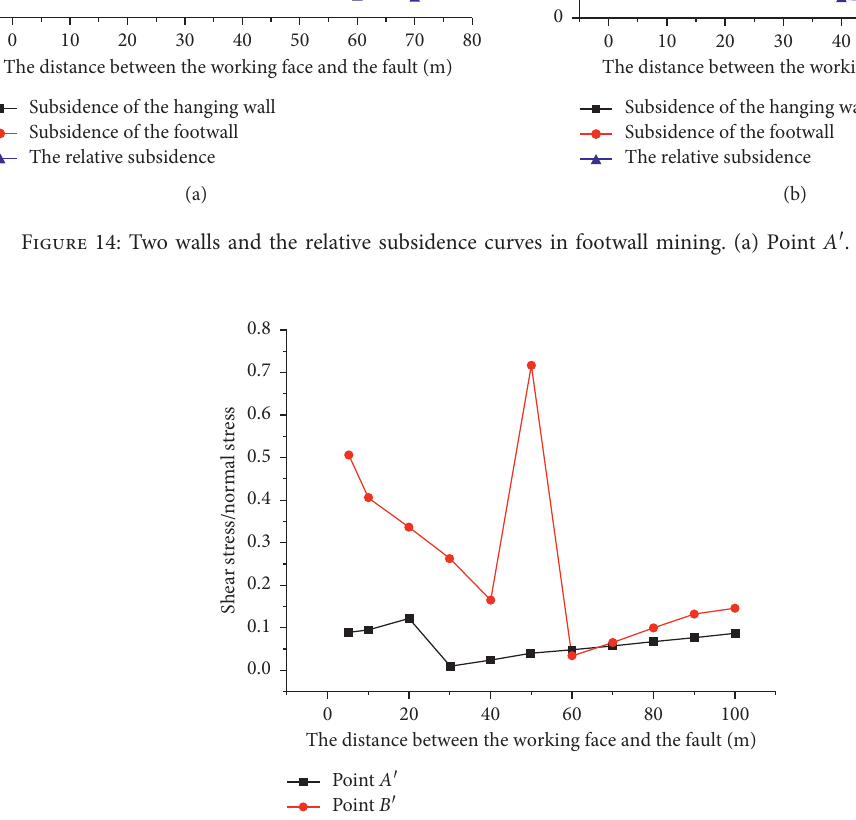
Figure 15: Ratio of shear stress to normal stress in footwall mining.